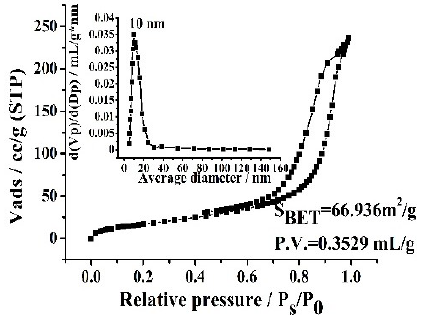
Figure 2. Nitrogen adsorption-desorption isotherms and pore distributions of Fe 3 O 4 @ CTS/SiO 2 -C 12 composite.